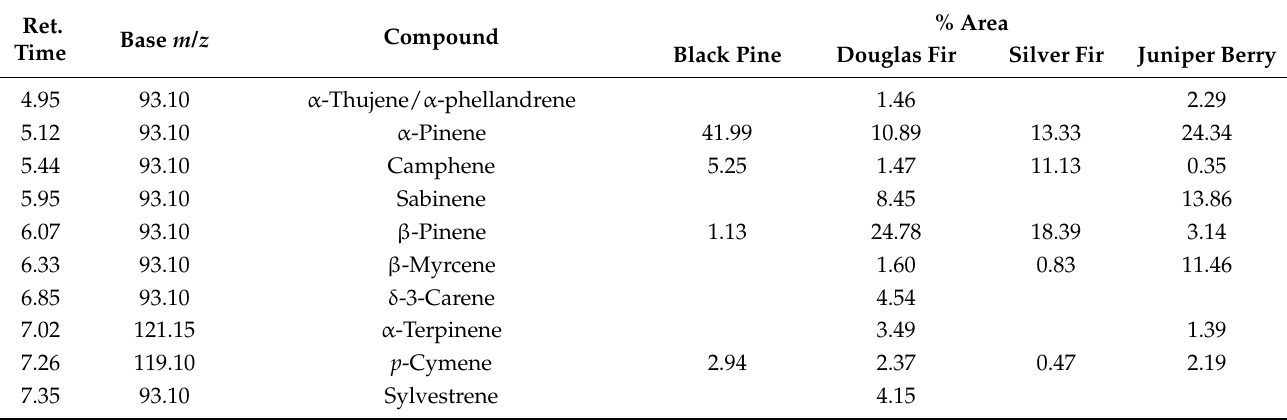
Table 1. Main constituents of the studied essential